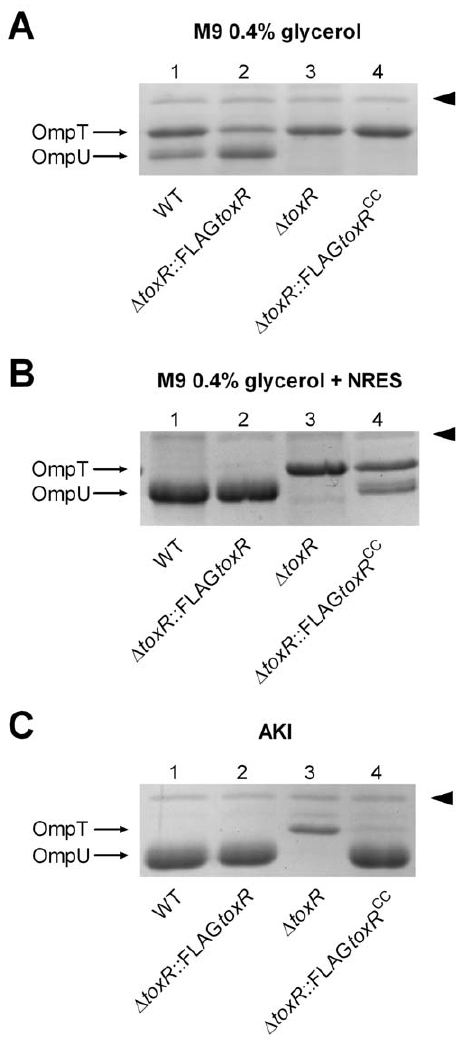
Figure 4. Chromosomal expression of FLAG toxR and FLAG- toxR CC and porin regulation. Panel A, B and C, shown are OMP profiles derived from OM preparations, representing WT, D toxR ::FLAG- toxR , D toxR and D toxR ::FLAG toxR CC strains, grown to stationary phase in M9 glycerol (A), M9 glycerol NRES (B) and AKI (C) during the anaerobic growth phase, respectively. Arrows mark OmpU and OmpT. Arrowheads on the right indicate a ToxR independent protein band used as loading control.